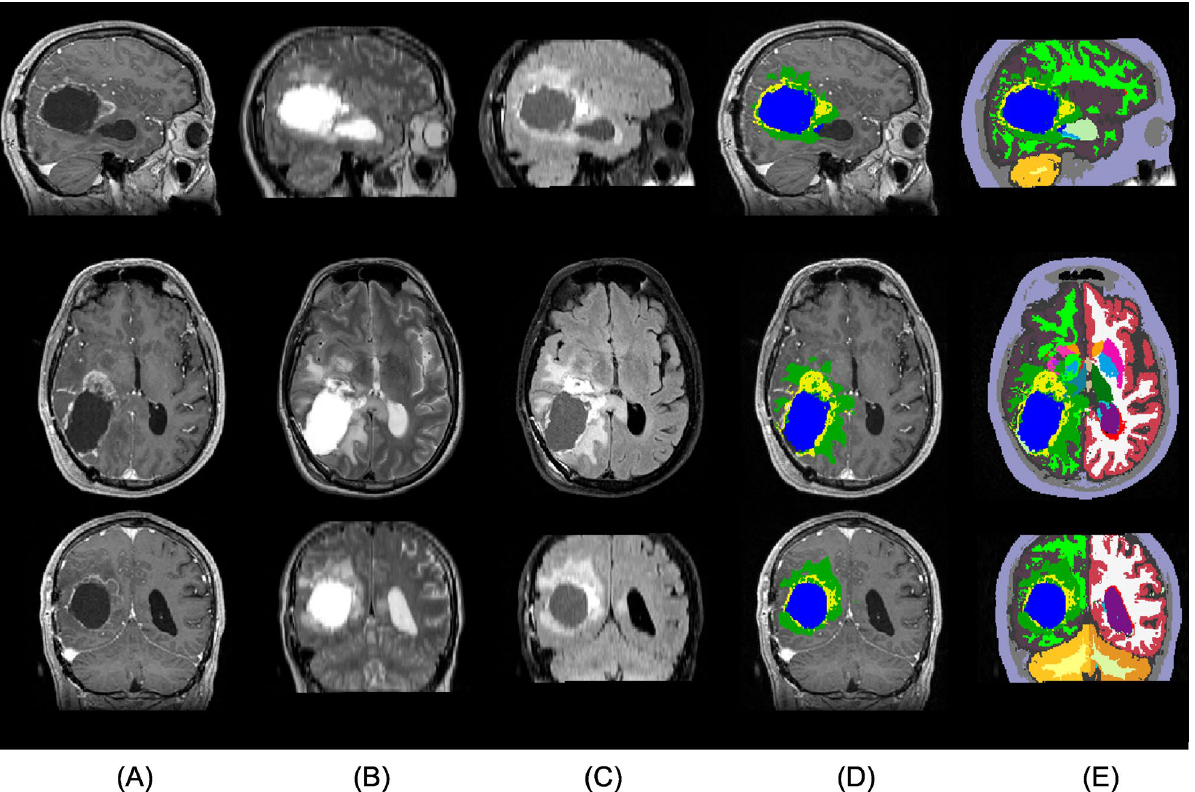
Figure 4. A sample from the Copenhagen (post-operative) dataset. From top to bottom: sagittal, axial, and coronal view. The columns show ( A ) T1c, ( B ) T2, ( C ) FLAIR, and ( D , E ) the automatic segmentation output. ( D ) shows the tumor components only, while ( E ) shows the full segmentation output. The tumor components in ( D , E ) are edema (green), enhancing core (yellow), and non-enhancing core (blue). Resection cavity is shown in light-green color in the sagittal view of ( E